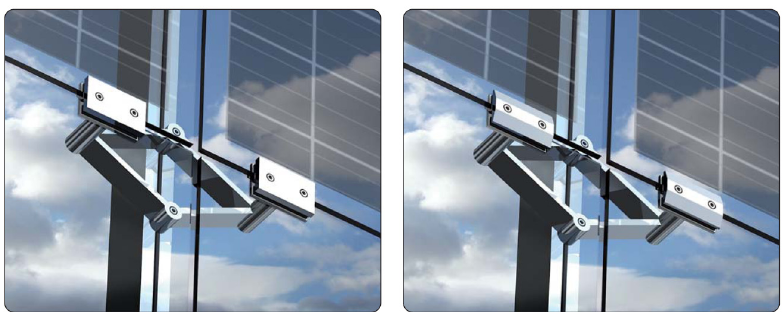
Figure.10: Clamp for